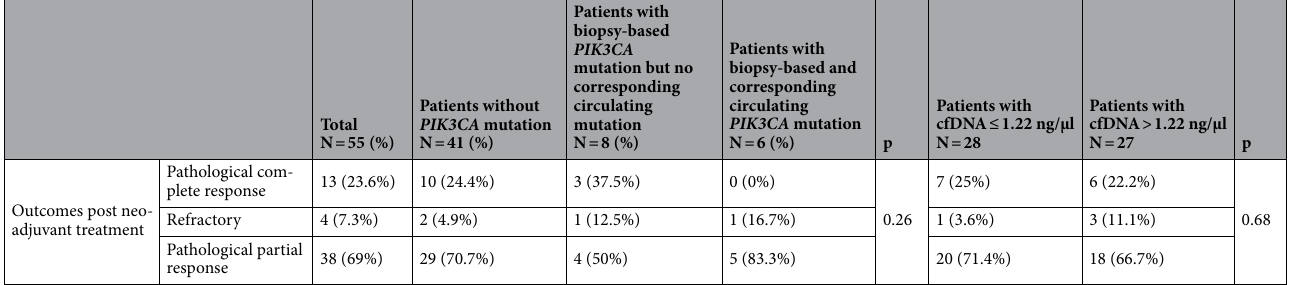
Table 3. Response to neoadjuvant chemotherapy according to PIK3CA mutation status and cfDNA rate. cfDNA cell-free DNA.